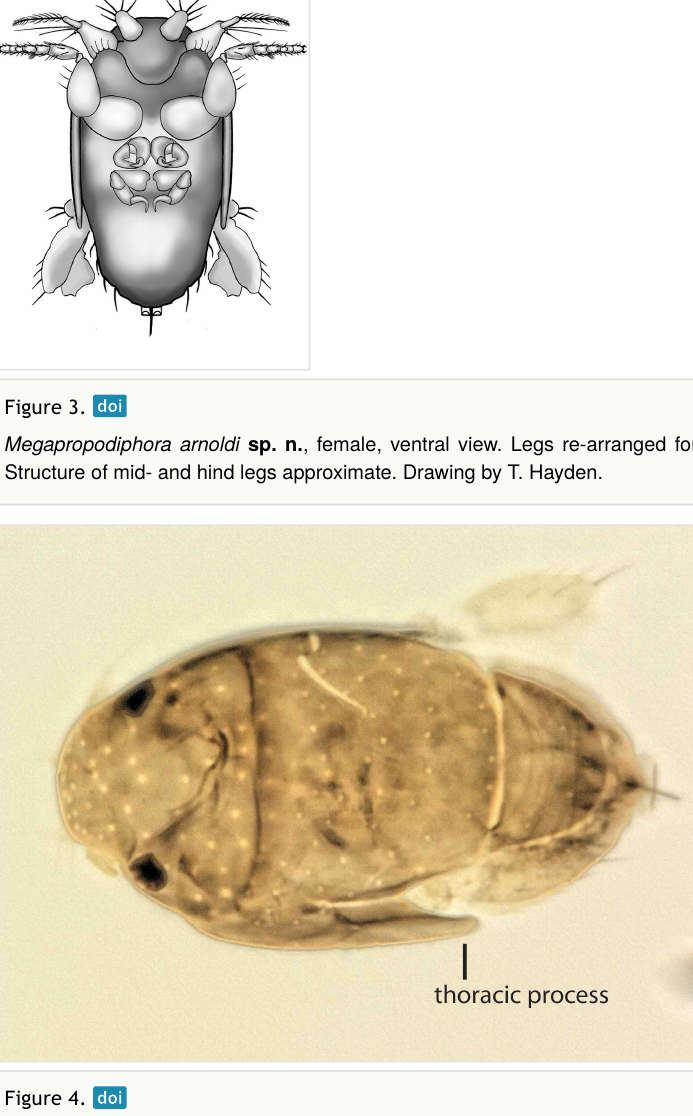
Figure 4. Megapropodiphora arnoldi sp. n. , female, dorsal, slightly oblique. Photomicrograph by B.